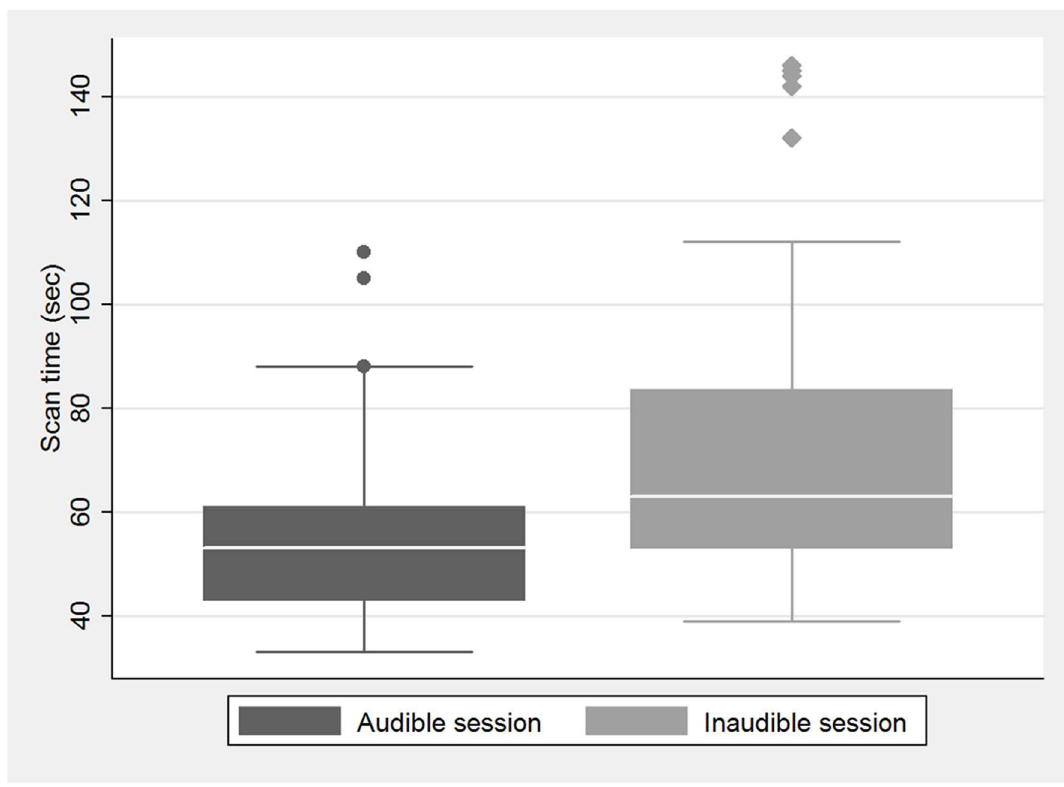
Fig 3. Scan time of audible and inaudible session. Box-and-whisker plots show scan time of the audibleand inaudible sessions of all 52 kidneys, the time neededto obtain reproducible waveforms is significantly shorter during the audiblethan the inaudiblesessions (p <